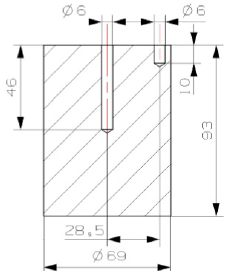
Table 3. Die temperature, lubricant, argon flow, solidus temperature (T S ), heating power, and temperature of the billet at the end of the heating cycle (T H ) for each tested steel.